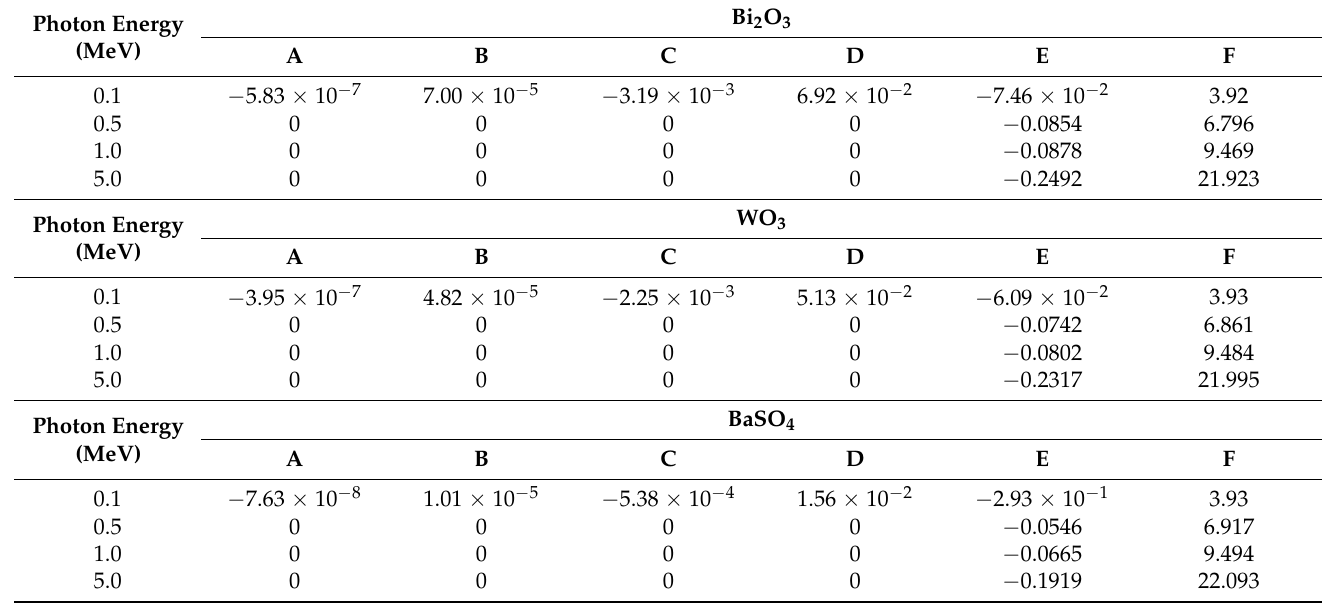
Table 6. Mathematical constants (A, B, C, D, and F) for HVL in the form HVL = A x 5 + B x 4 + C x 3 + D x 2 + E x + F (Equation (7)), determined from Figure 8.